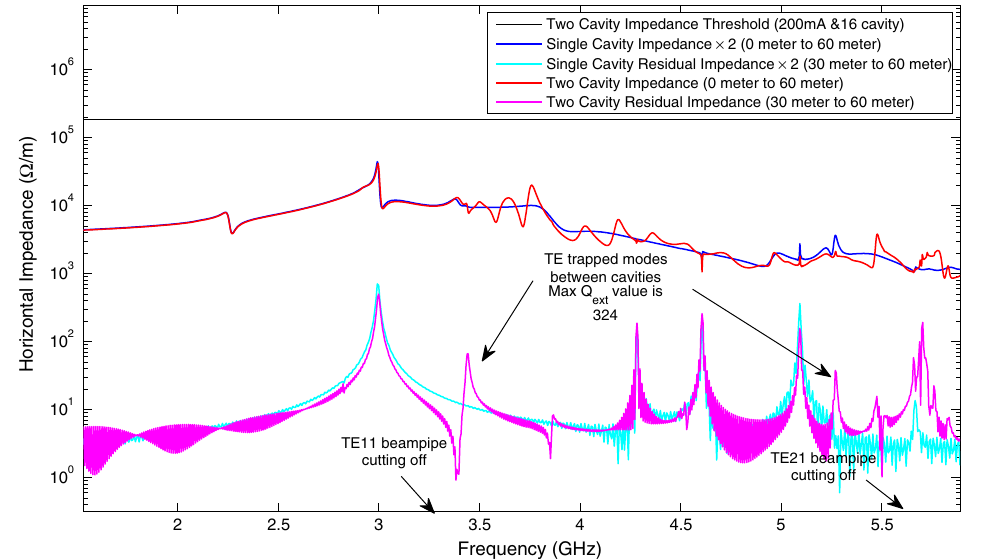
FIG. 17. Transverse impedance Z 1 ⊥ comparison between two-cavity model and single cavity model. The impedances are all based on the L ¼ 60 m wake potentials.